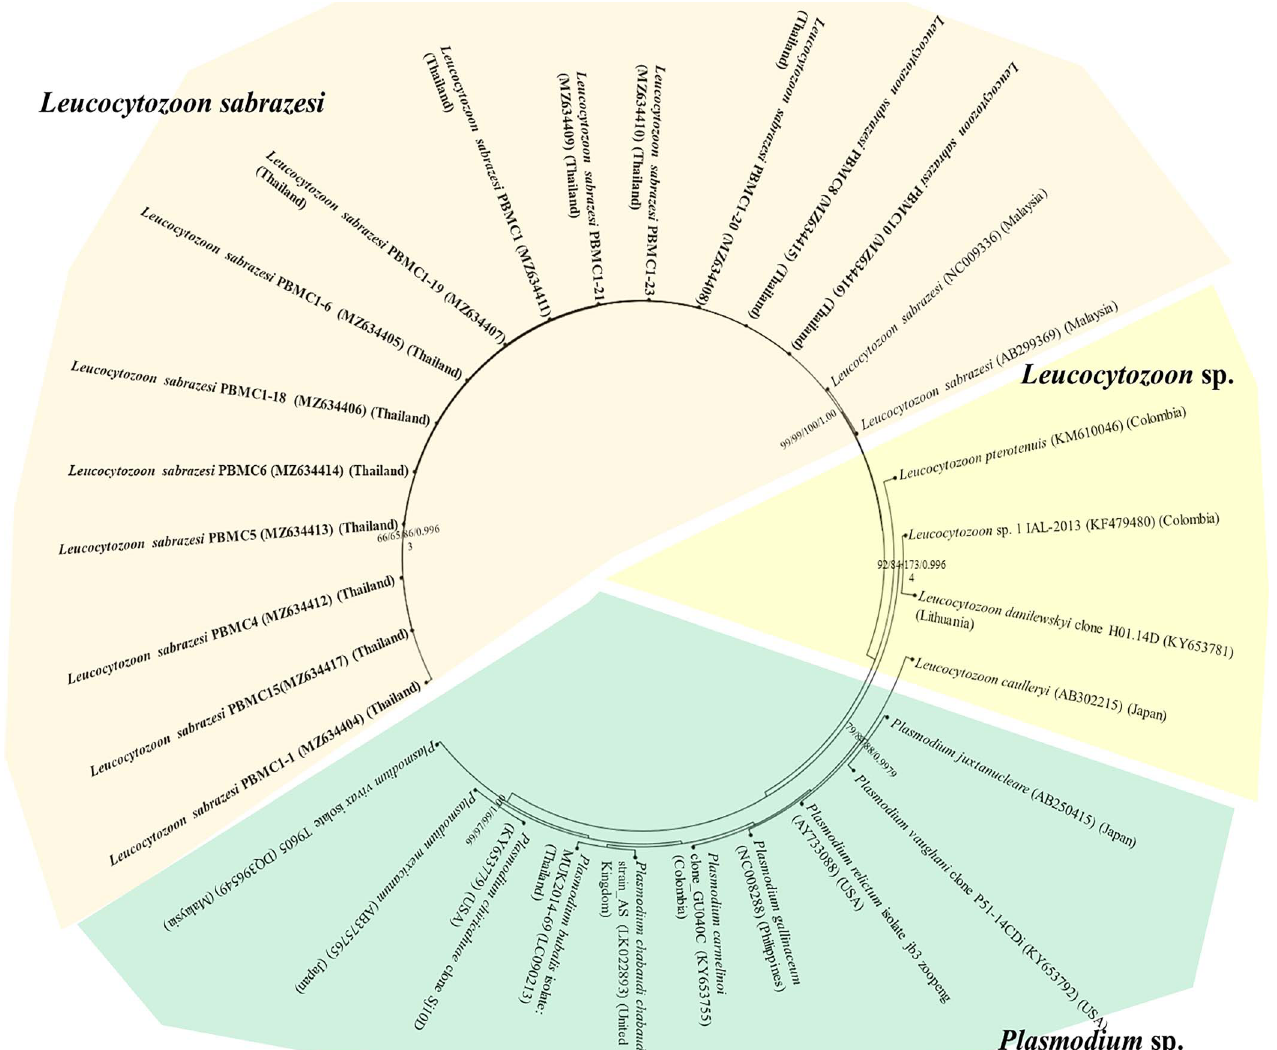
Fig. 3. Phylogenetic tree of the coxIII gene sequences in this study (bold face) and those taken from GenBank.The boostrap values calculated from NJ, ML, MP and BA are labeled on each